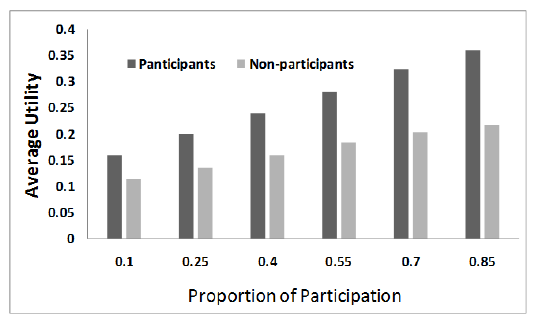
Fig. 2. Average utility of participating and non-participating peers.